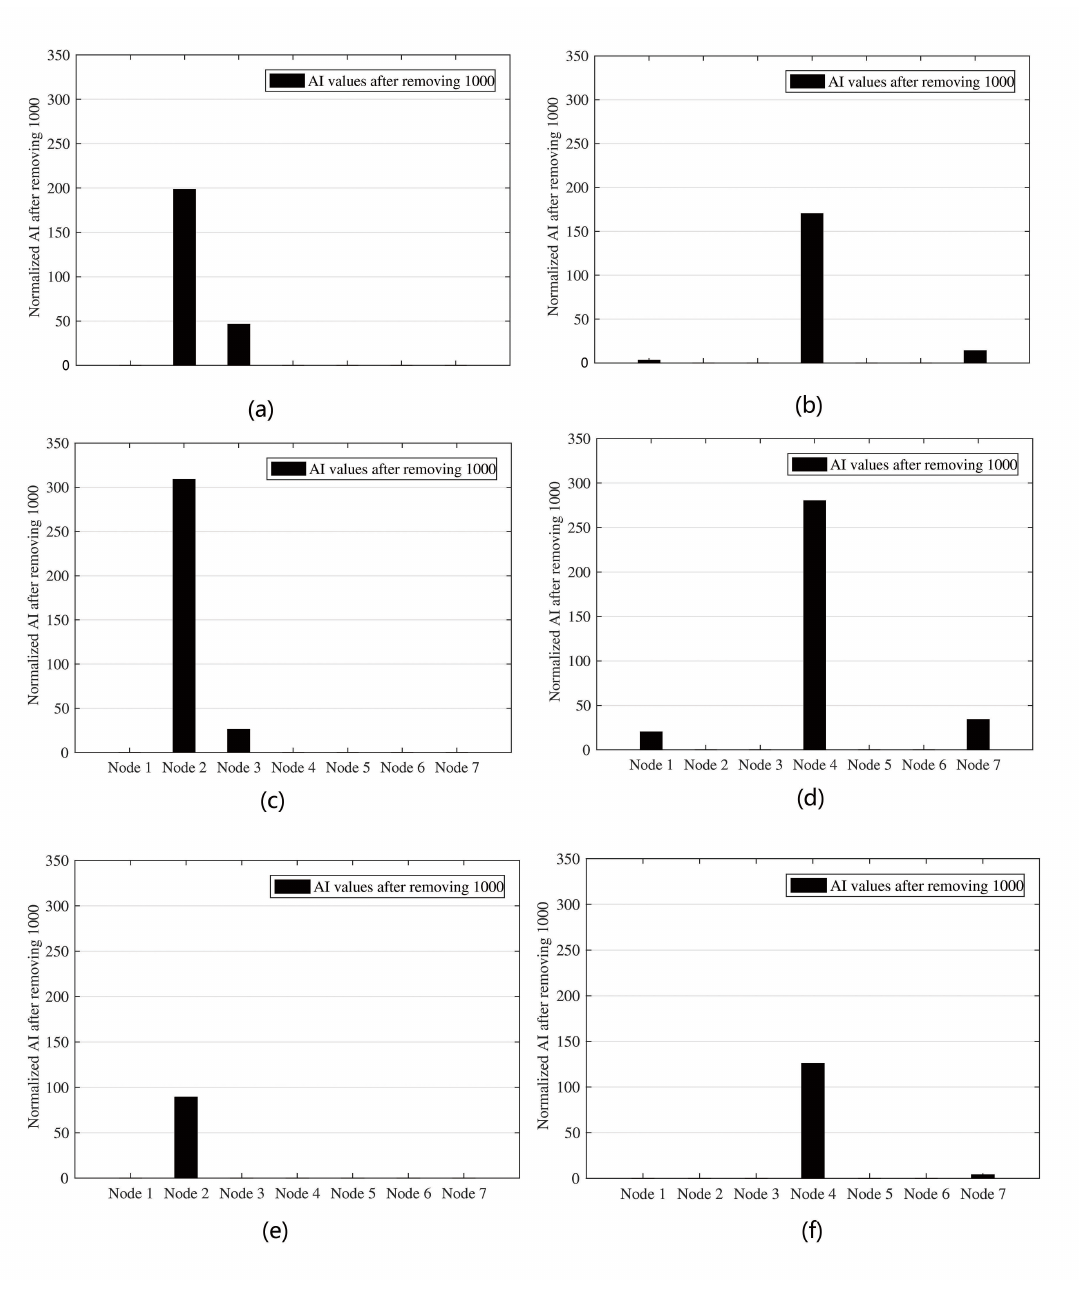
Figure 18. Normalized AI for six different damage scenarios obtained from laboratory models. ( a , c , e ) Cases N2D7-7, N2D5-7, and N2D3-7 of laboratory model; ( b , d , f ) cases N4D7-7, N4D5-7, and N4D3-7 of a laboratory